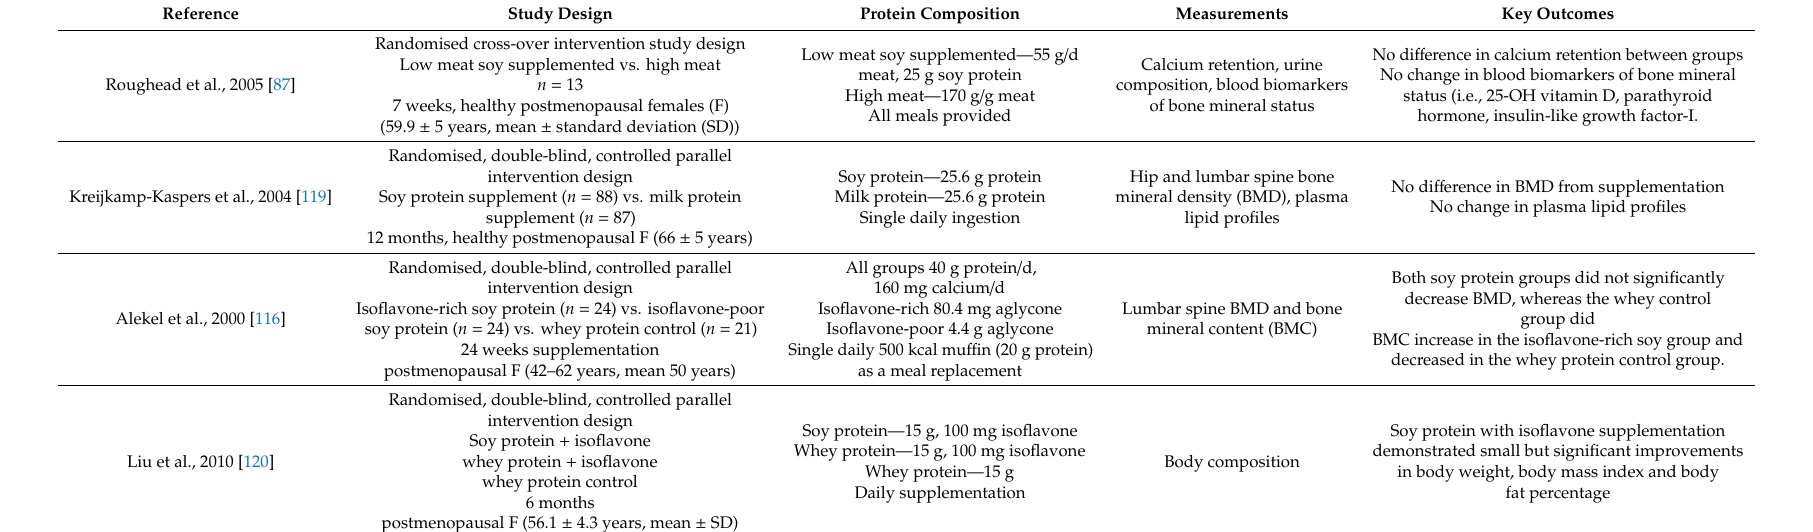
Table 4. Plant-derived proteins: e ff ects on bone in relation to age, exercise, energy restriction and